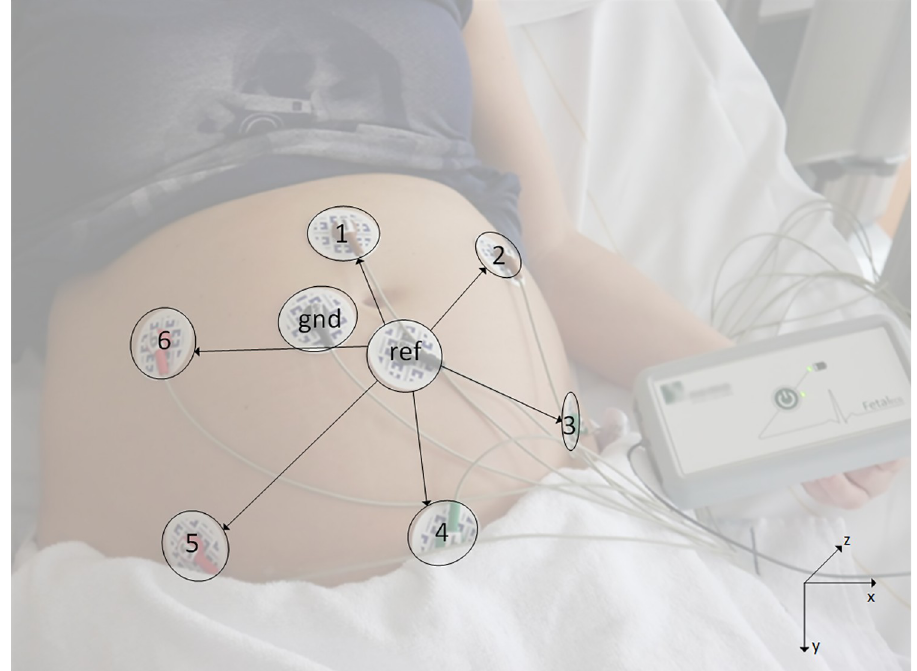
Fig 1. Measurement set-up of the non-invasive fetal electrocardiogram. Eight electrodes were placed on the maternal abdomen in a fixed configuration. Two electrodes served as common reference (Ref) and ground (Gnd). The cartesian coordinate system as used in our analyses is displayed in the bottom right corner